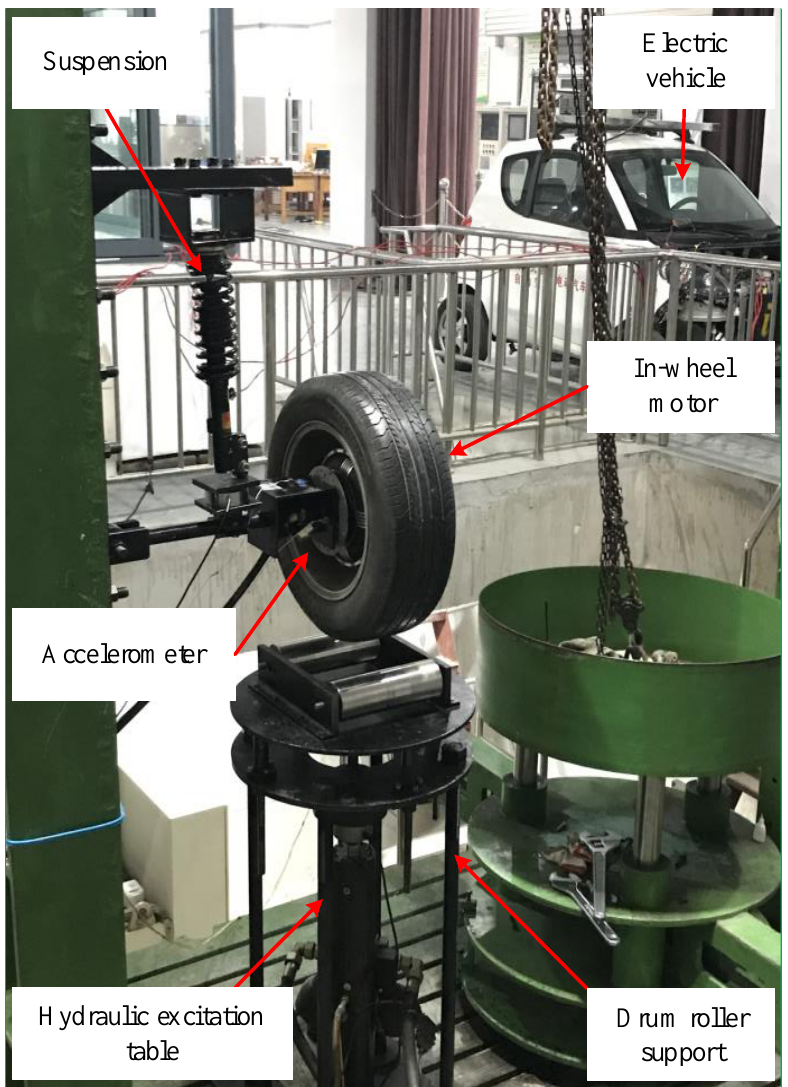
Figure 3. In-wheel motor test bench.